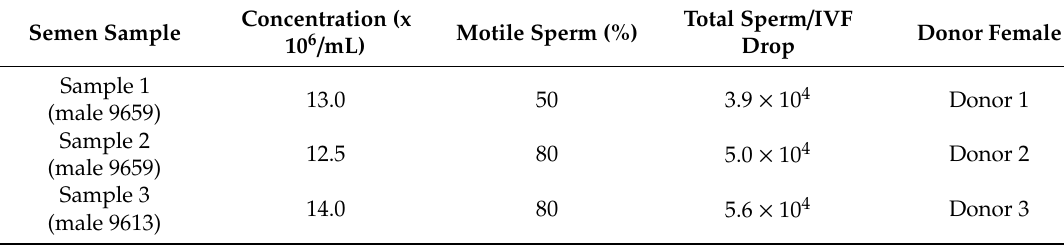
Table 3. Sperm metrics post-thawing and after swim-up